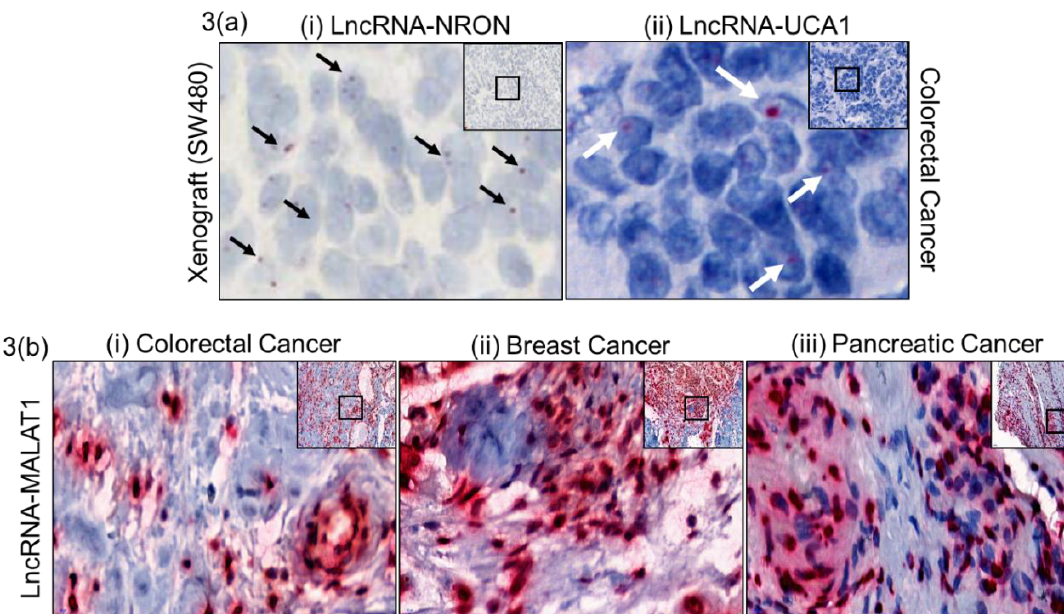
Figure 3. Paraffin embedded different human cancer tissues that have been Z probe stained for different lncRNAs. ( a ) Tumor suppressor lncRNA NRON (very low expression, non-coding repressor of NFAT) ( i ) and oncogenic lncRNA UCA1 (moderately expressed, urothelial cancer associated 1) ( ii ) stained in colorectal cancer tissue. ( b ) LncRNA MALAT1 (metastasis associated lung adenocarcinoma transcript 1) stained using specific Z-probes in paraffin embedded ( i ) colorectal cancer, ( ii ) breast cancer and ( iii ) pancreatic cancer tissues. 20× (inset) and 80× magnification using CaseViewer 2.2 software, scanned and analyzed on Pannoramic 250 Flash III. Arrows point at specific lncRNA signals.